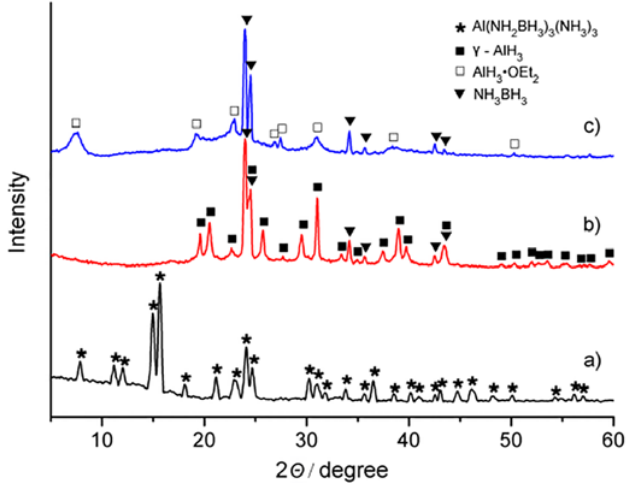
Figure 1. XRD patterns of ( a ) as-prepared Al(NH 2 BH 3 ) 3 ·3NH 3 ; ( b ) mixture of γ -AlH 3 + 3NH 3 BH 3 ; ( c ) ball milled AlH 3 ·OEt 2 + 3NH 3 BH 3 . λ = 1.5406